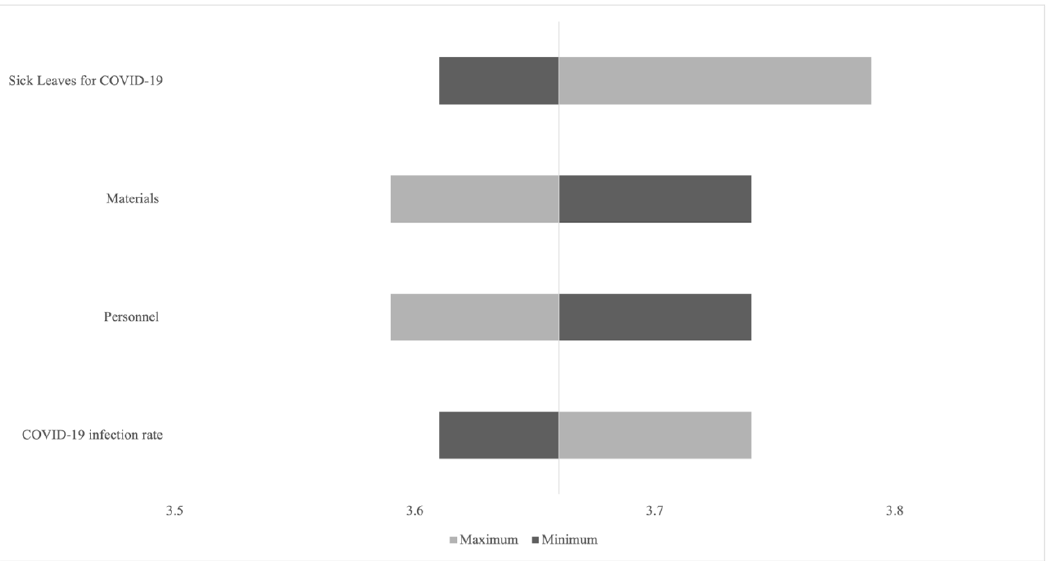
Figure 1. Tornado chart showing a set of univariate deterministic sensitivity analyses. The vertical line represents the base-case SRPI (EUR 3.66), while the tails of each bar show the changes in SROI when each parameter is varied.